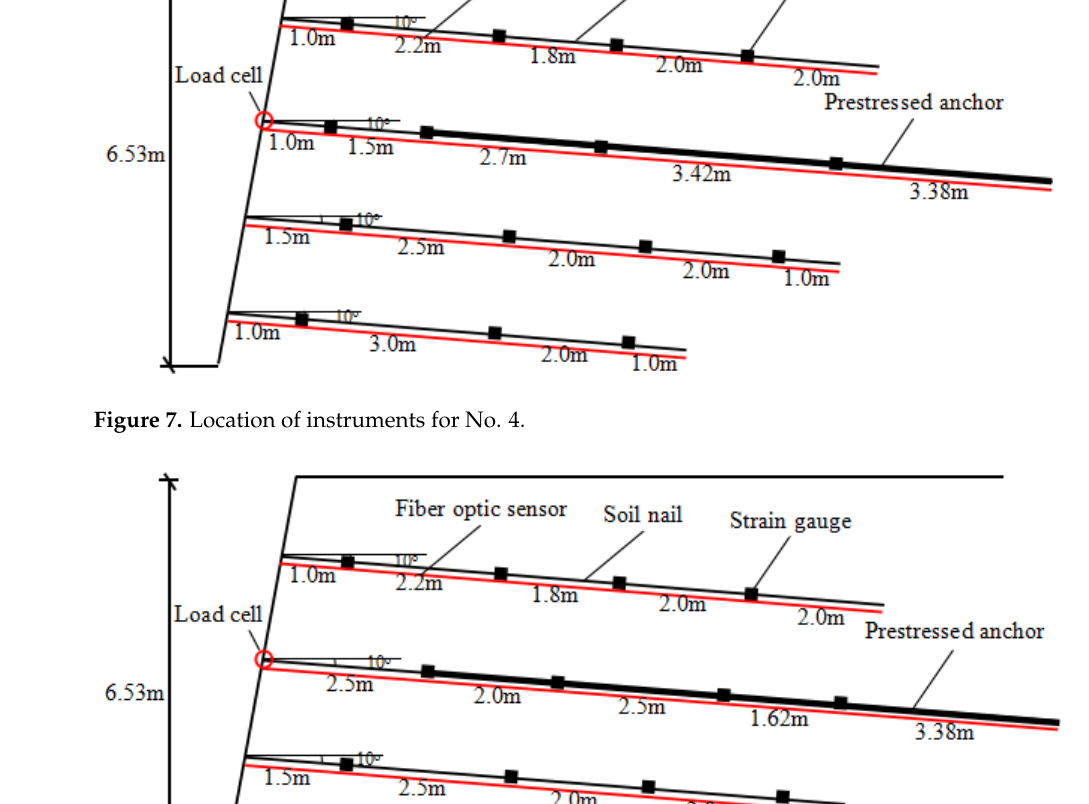
Figure 6. Location of instruments for No. 1.